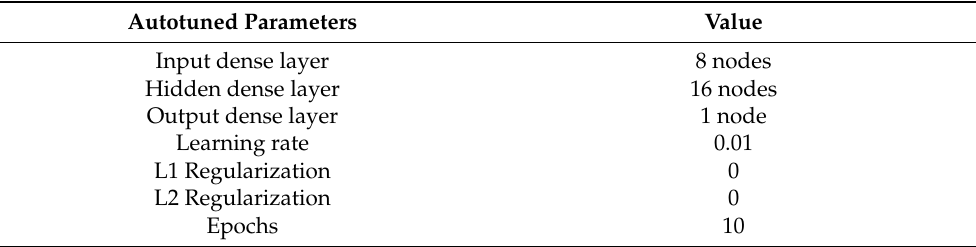
Table 2. Model architecture where Kfold = 5, random seed = 42, loss function = MSE, optimizer = Levenberg–Marquardt algorithm, momentum = enabled, early stopping = 10 rounds, autotuning objective function = MSE, autotuning algorithm: grid search, BatchNorm = disabled.